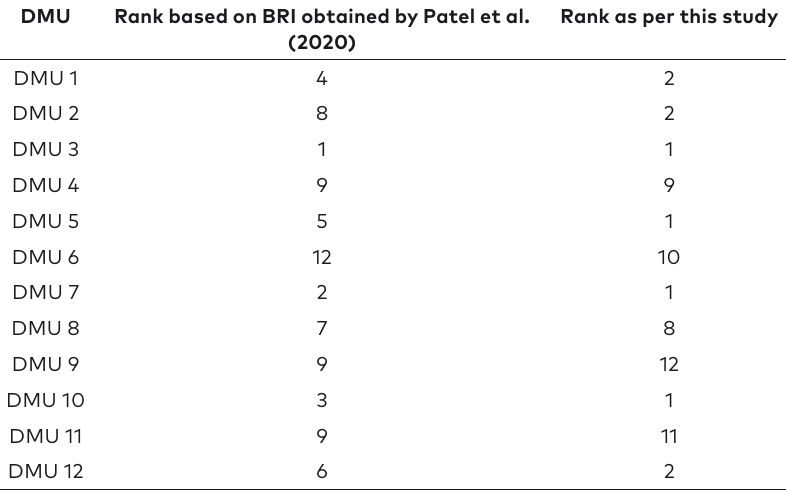
Table 6. Rank comparison between the current study and BRI score DMU Rank based on BRI obtained by Patel et